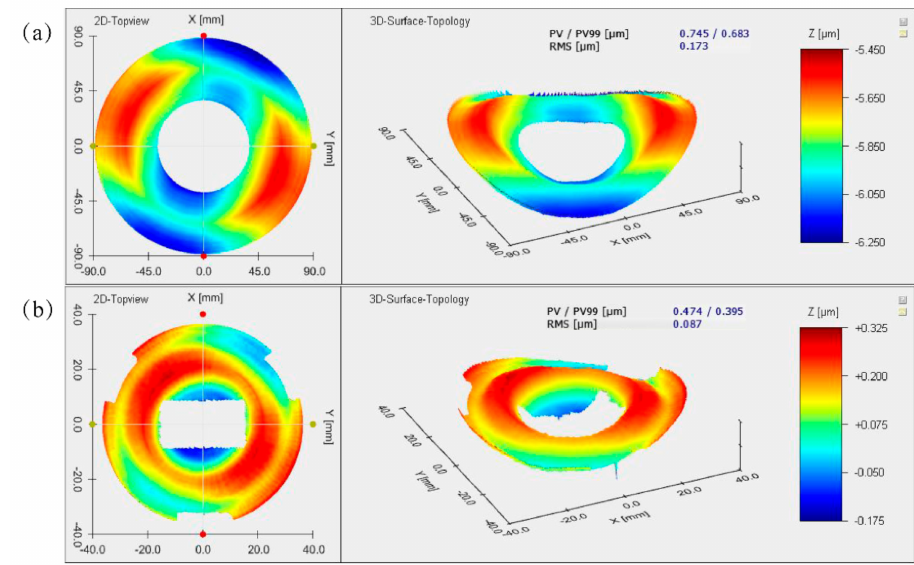
Figure 15. Surface shape deviation after the second Round SPDT: ( a ) PM; ( b ) TM.